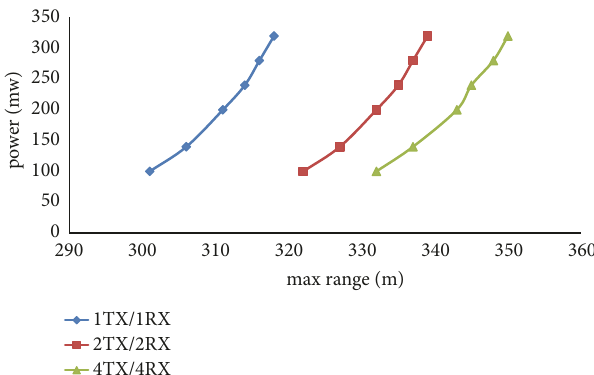
Figure 10: Power (mw) and max range (m) at wavelength=850nm and attenuation=266.5 db/km (heavy